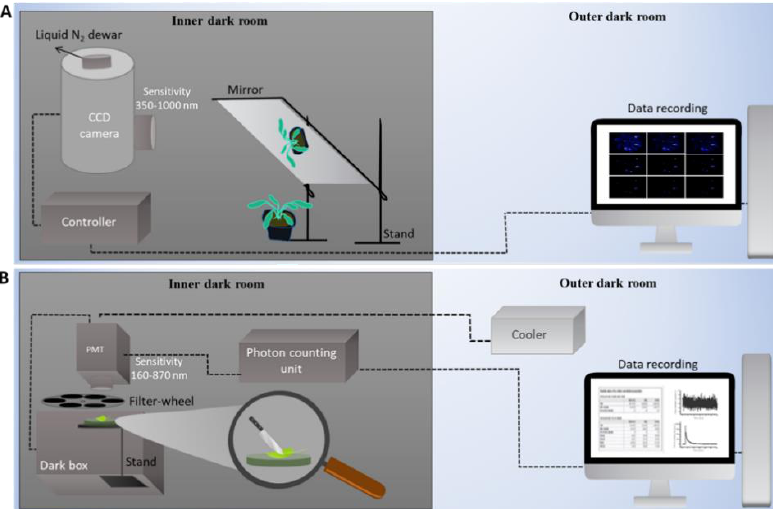
Figure 1. Schematic illustration of the experimental setup for two-dimensional imaging ( A ) and measurements of kinetics ( B ) of ultra-weak photon emission. The two-dimensional ultra-weak photon emission was measured using charge-coupled device (CCD) camera and the kinetic measurements of ultra-weak photon emission was measured using photomultiplier tubes (PMT) with a cut-on filter system.